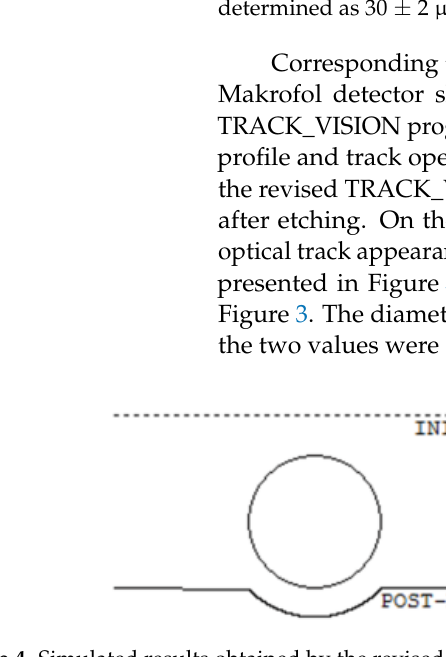
Figure 4. Simulated results obtained by the revised TRACK_VISION program corresponding to those alpha-particle tracks developed on an irradiated and etched Makrofol detector shown in Figure 3. Left panel: track profile and track opening (the latter being a circle due to normal incidence), together with the position of the detector surface before and after etching. Right panel: optical track appearance, which consists of a wide, dark ring and a bright area at the track center. Vertical left bar represents 34 μ m.